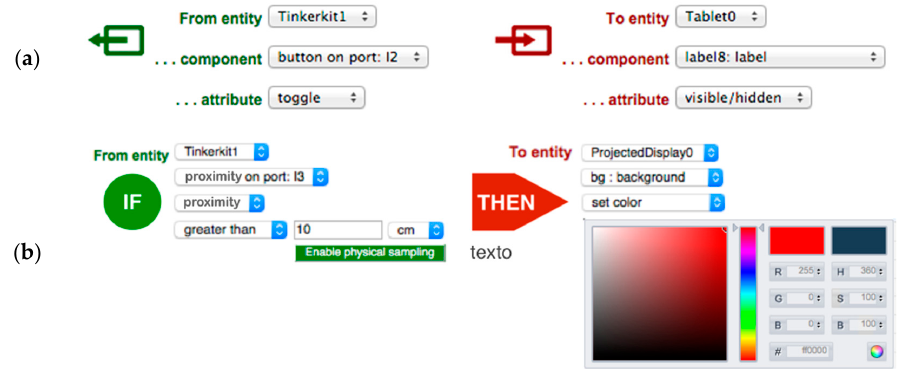
Figure 6. Screenshot of the interface for configuring cross-device behaviors. ( a ) A direct mapping: The button on port I2 (see Figure 3) is used to toggle the visibility of a label on the graphical interface of a tablet; ( b ) A trigger-action: If I am at more than 10 cm from the distance sensor change the background of the projected display to “red”.